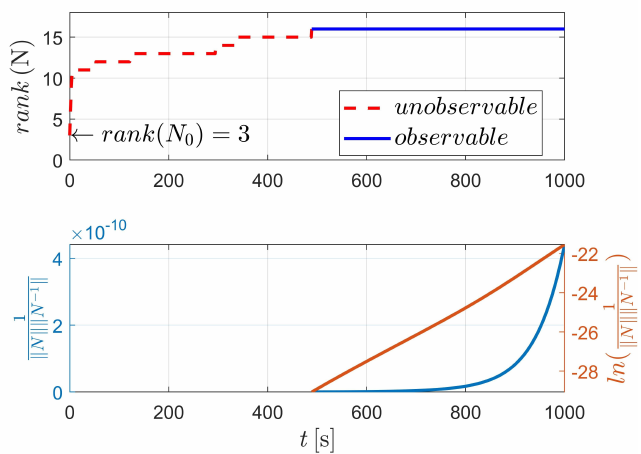
Figure 9. Observability simulation of case III (with J 2 , J 3 , and J 4